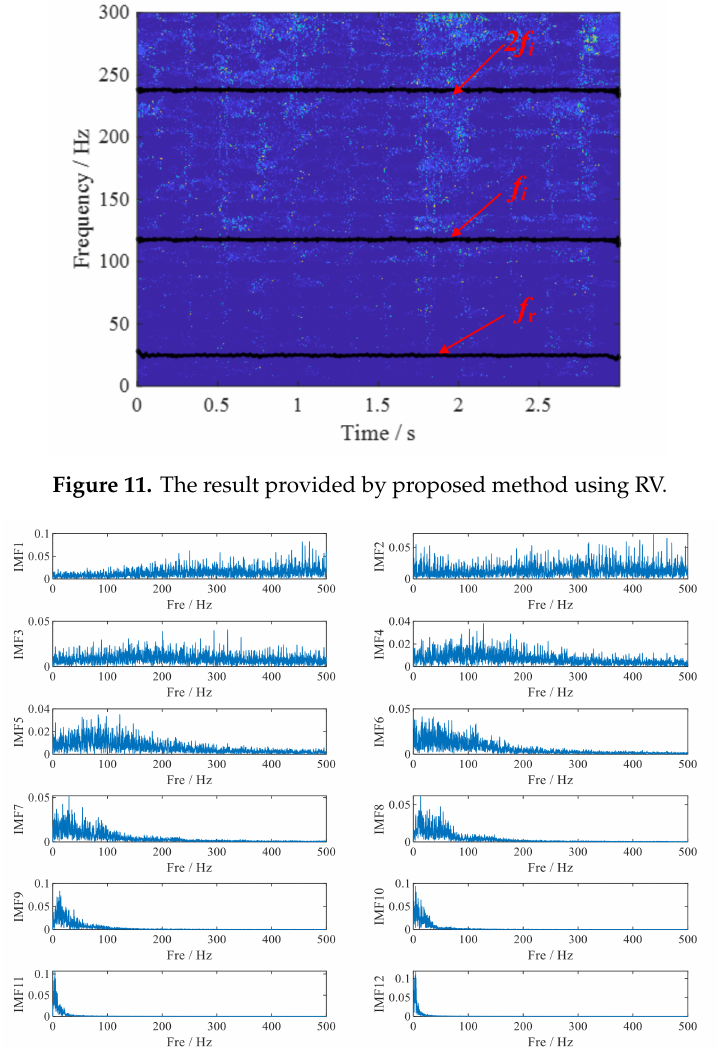
Figure 12. The result provided by